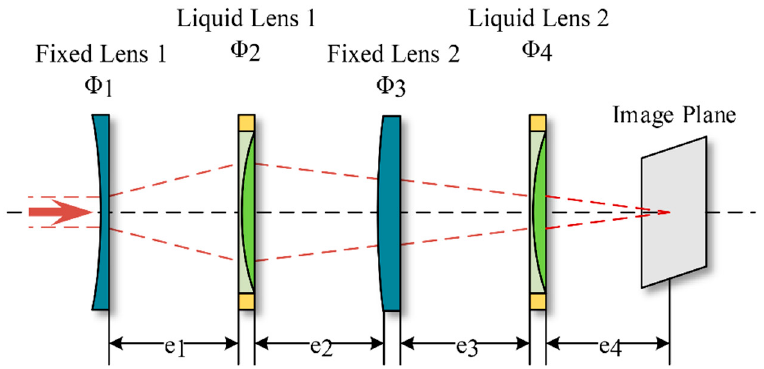
Figure 1. Structure of the zoom system.